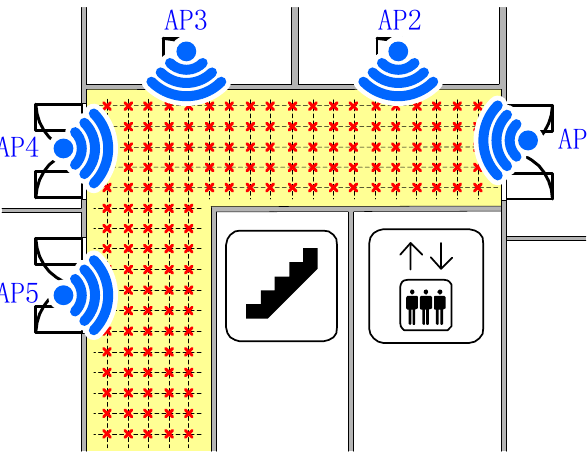
Figure 7. Floor plan for indoor localization, where the area colored in yellow is used for testing.